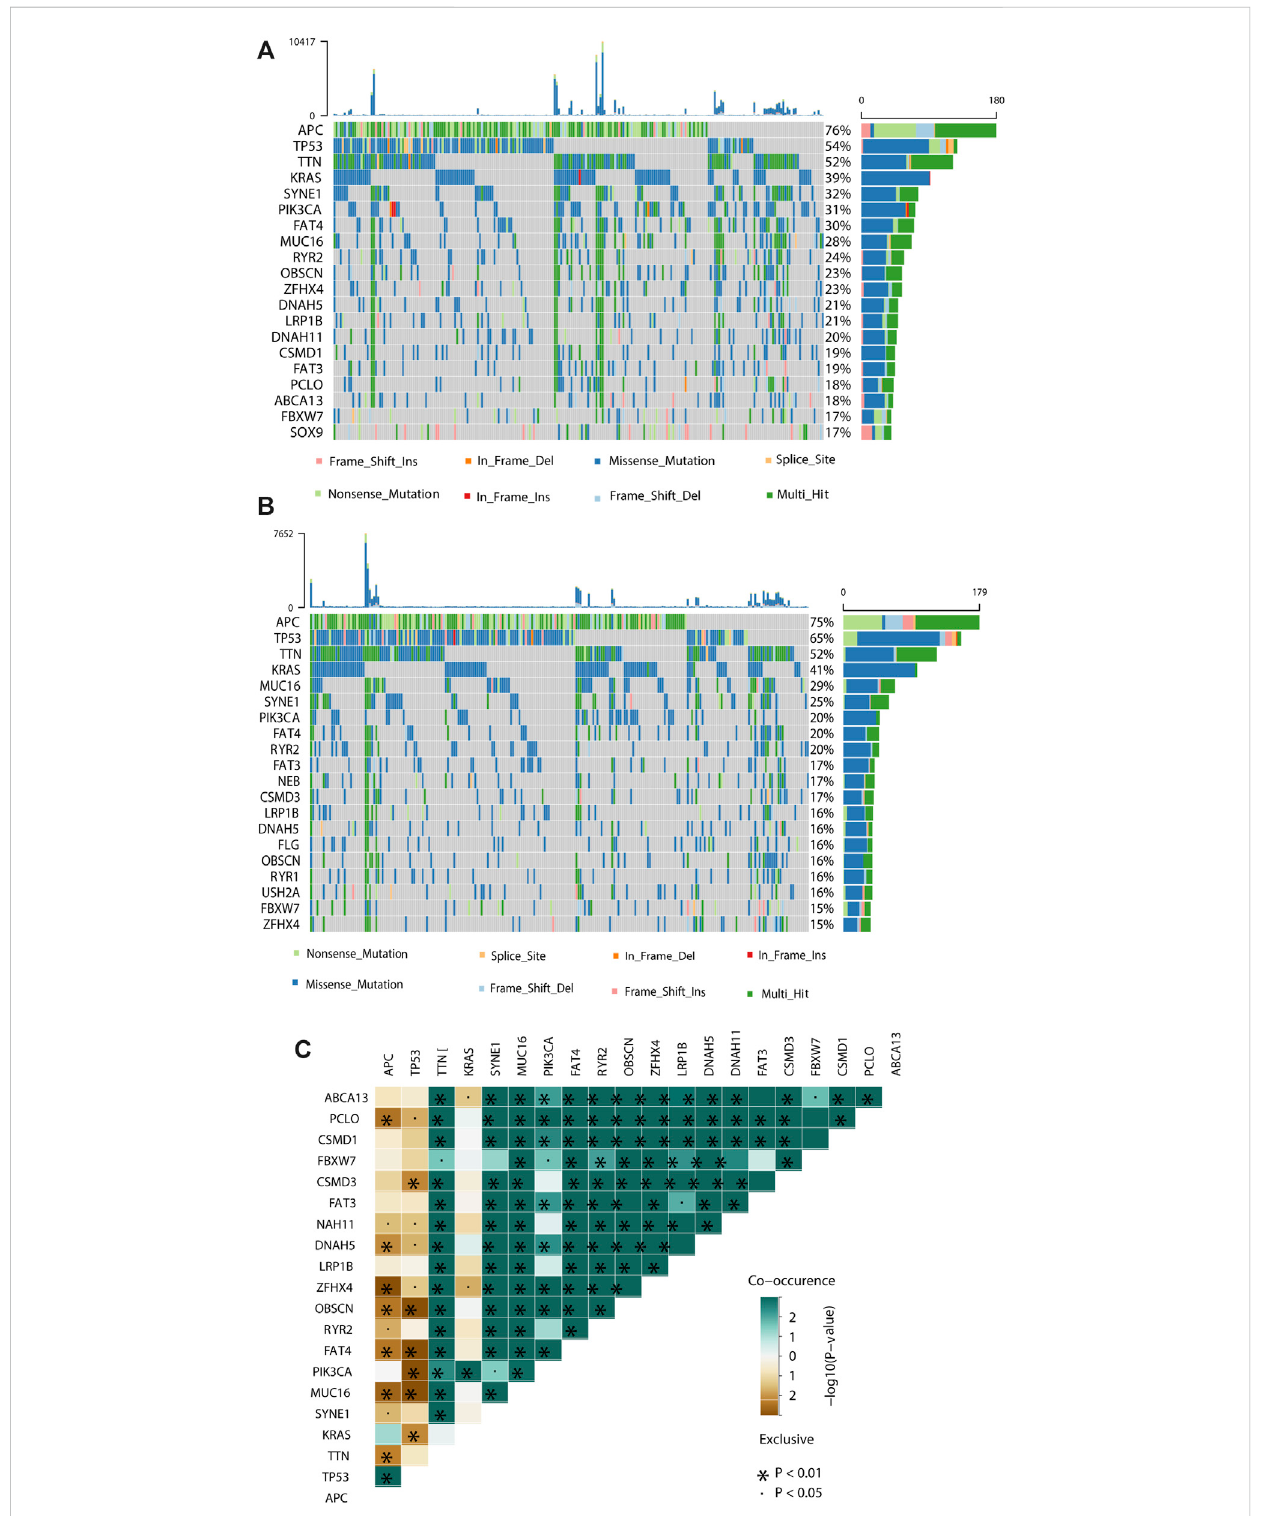
FIGURE 4 Molecular characteristics of different risk subgroups. (A, B) Waterfall plot displays tumour somatic mutation information of the genes with high mutation frequencies in the high-risk subgroup (A) and low-risk subgroup (B) . Mutated genes (rows, top 20) are ordered by mutation rate; samples (columns) are arranged to emphasize mutual exclusivity among mutations. The right shows the mutation percentage, and the top shows the overall number of mutations. The color coding indicates the mutation type. (C) The co-expression patterns of top 20 mutated genes in CRC